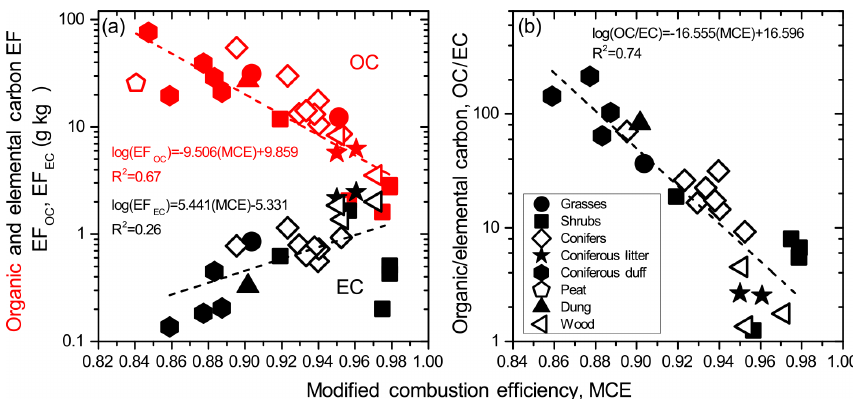
Figure 1. (a) Measured organic and elemental carbon (OC and EC, respectively) as a function of modified combustion efficiency (MCE) and (b) OC / EC as a function of MCE. Symbols indicate the different fuel